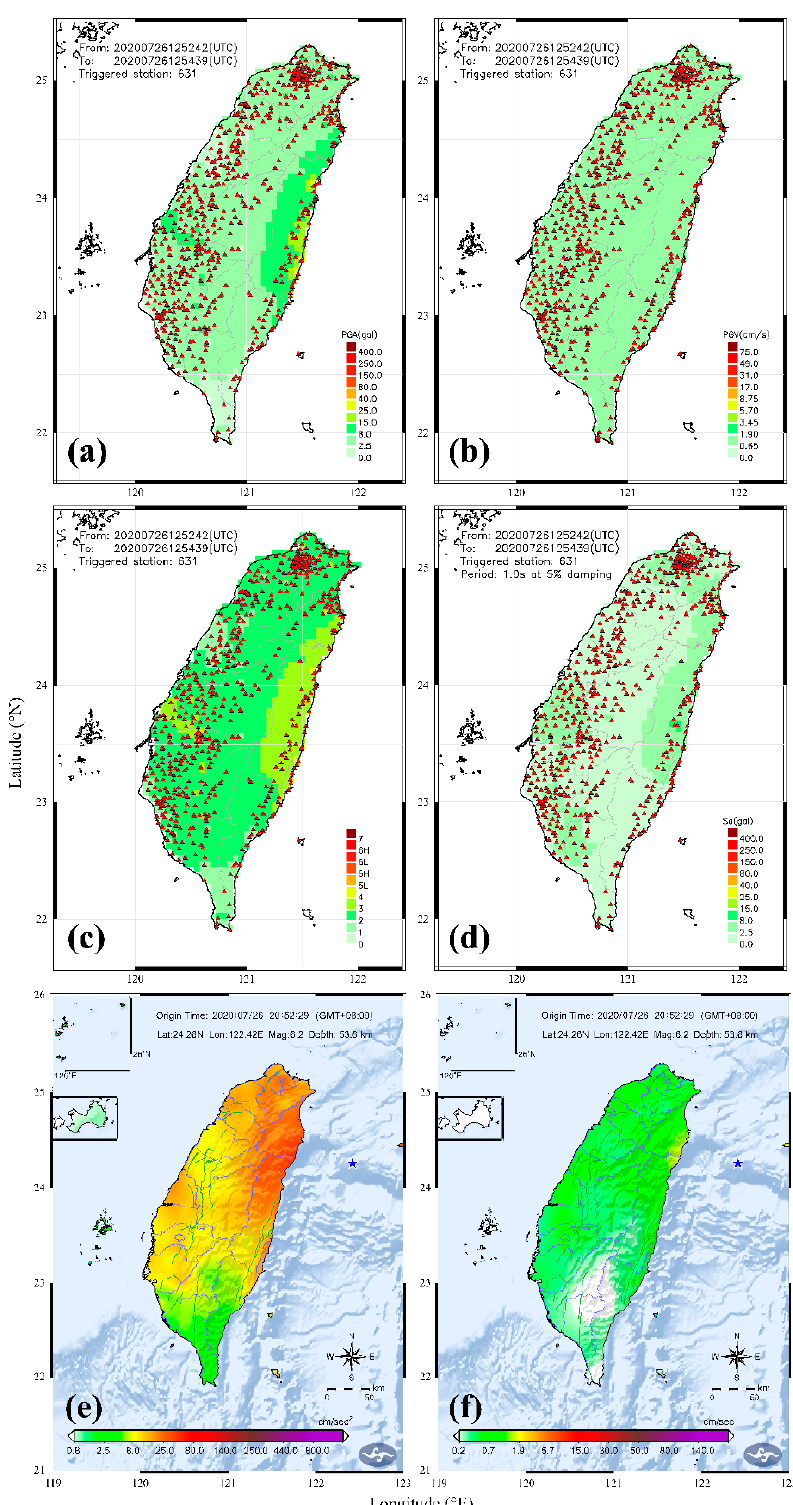
Figure 5. The real-time PGA ( a ), PGV ( b ), Intensity ( c ), and S a ( d ) maps available within approxi- mately 2 min of the occurrence of the earthquake. The earthquake started at 12:52:29 and the final shakemaps were available at 12:54:39 with a total triggering of 631 stations. The PGA ( e ) and PGV ( f ) shakemaps were posted by CWB at 12:57:52.